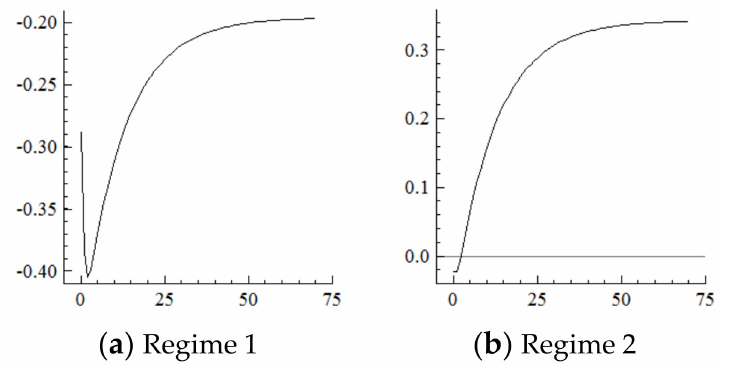
Figure 10. Cumulative Impulse Response of Industrial Structure Upgrading Industrial structure upgrading to Consumption